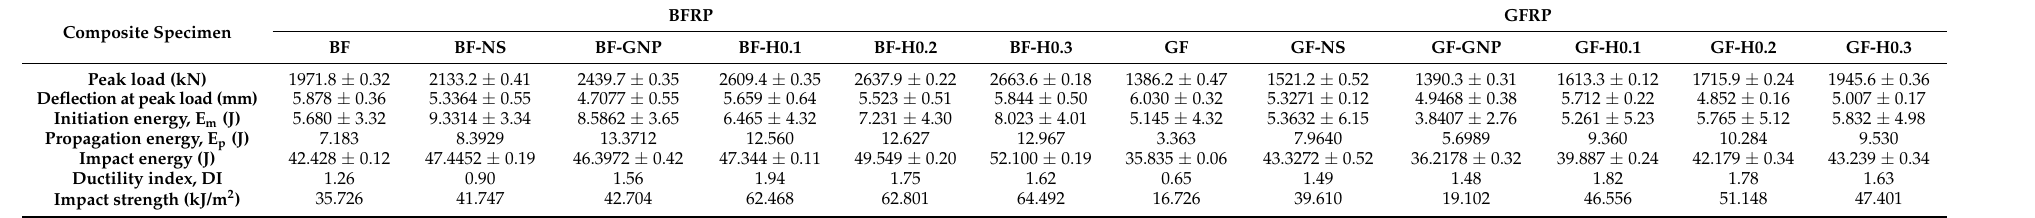
Table 7. Impact properties of FRP composites embedded with hybrid